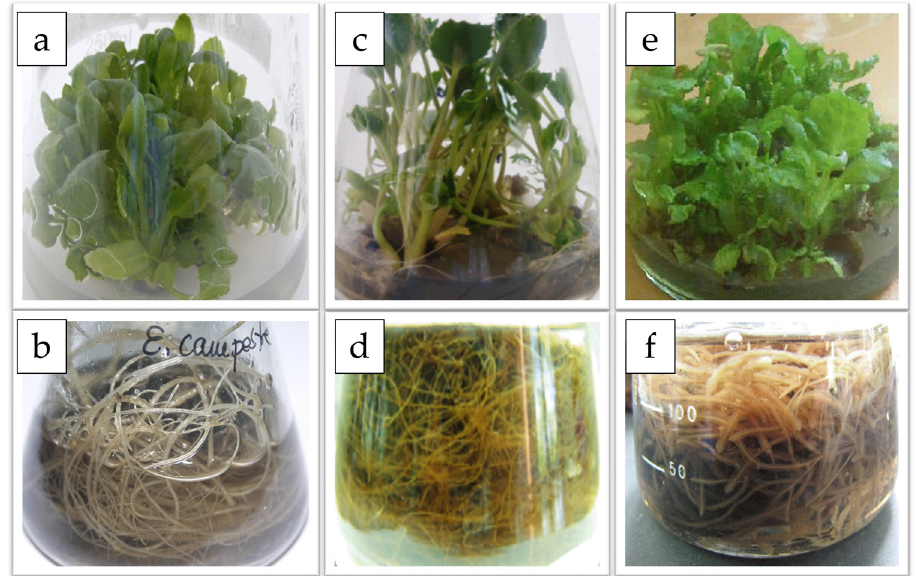
Figure 1. In vitro shoot and root cultures of: ( a , b ) Eryngium campestre L.; ( c , d ) Eryngium maritimum L.; ( e , f ) Eryngium planum L. Table 1. The growth parameters of stabilized in vitro shoot cultures of Eryngium species. Explants that Species Studied Proliferated Buds